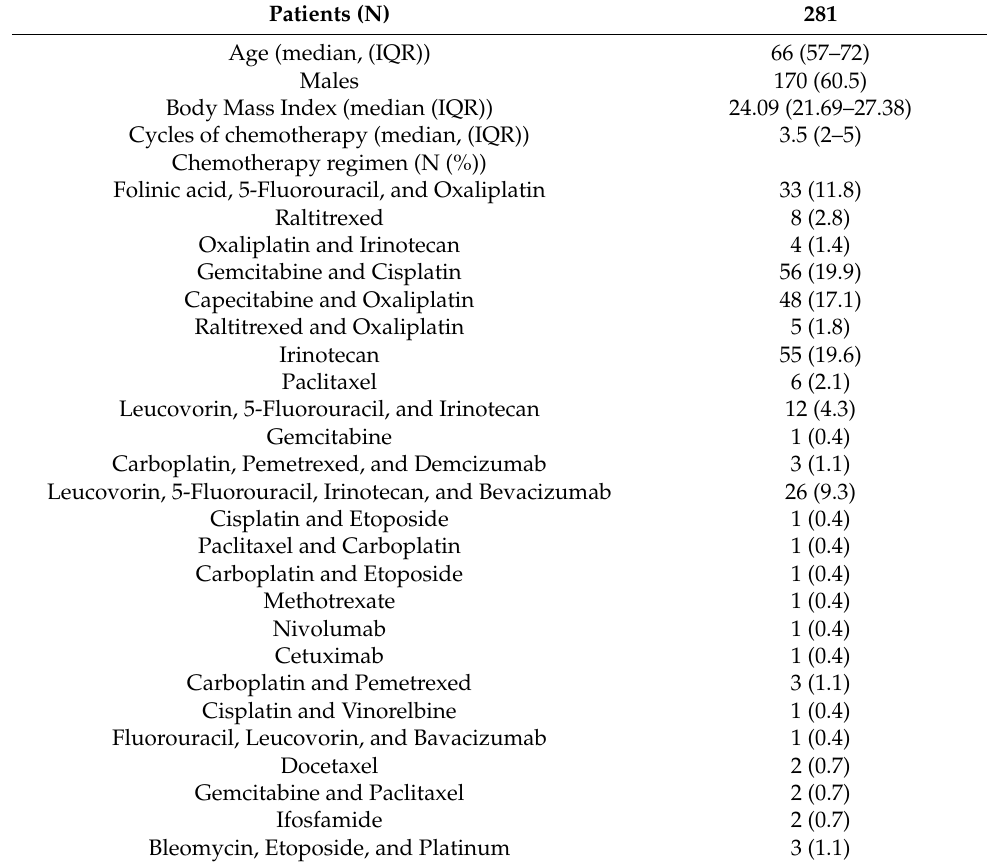
Table 1. Demographic, clinical, and pharmacological description of the enrolled